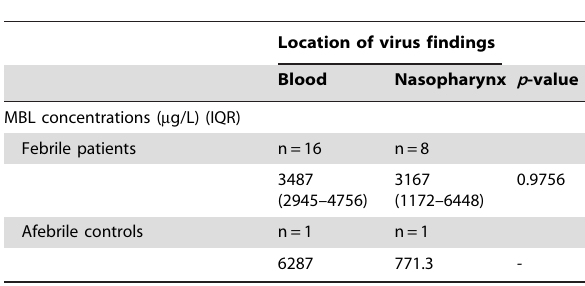
Table 4. Plasma MBL concentrations in wildtype (A/A) individuals with virus findings.